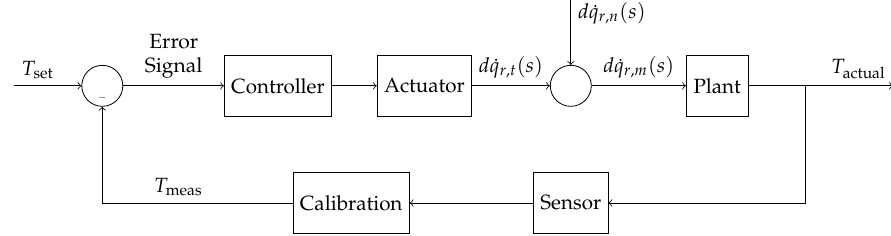
Figure 5. Etalon control system block diagram identifying main components and relevant